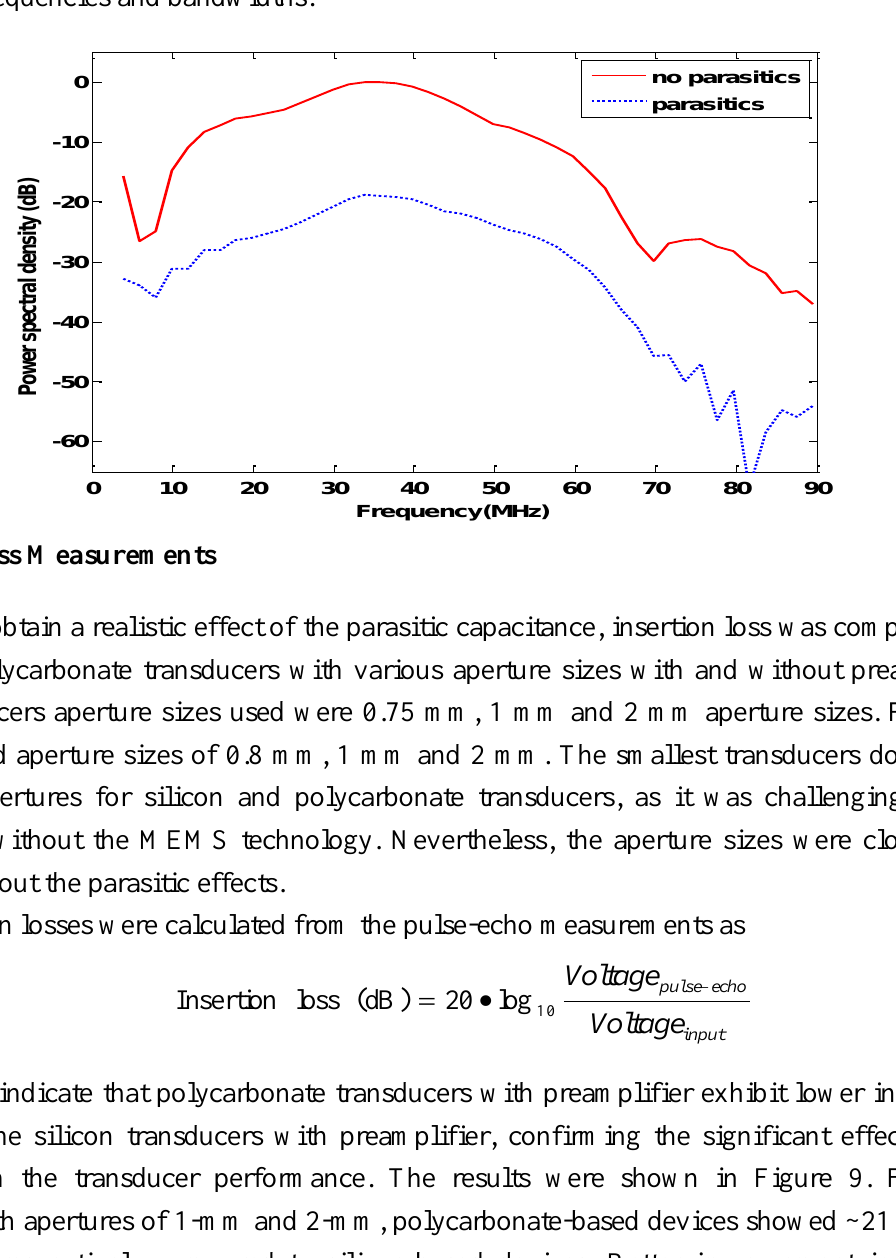
Figure 8. Power spectral densities of polycarbonate (no parasitics) showing signal loss compared to and Silicon (parasitic) transducers. Both of them have nearly identical center-frequencies and